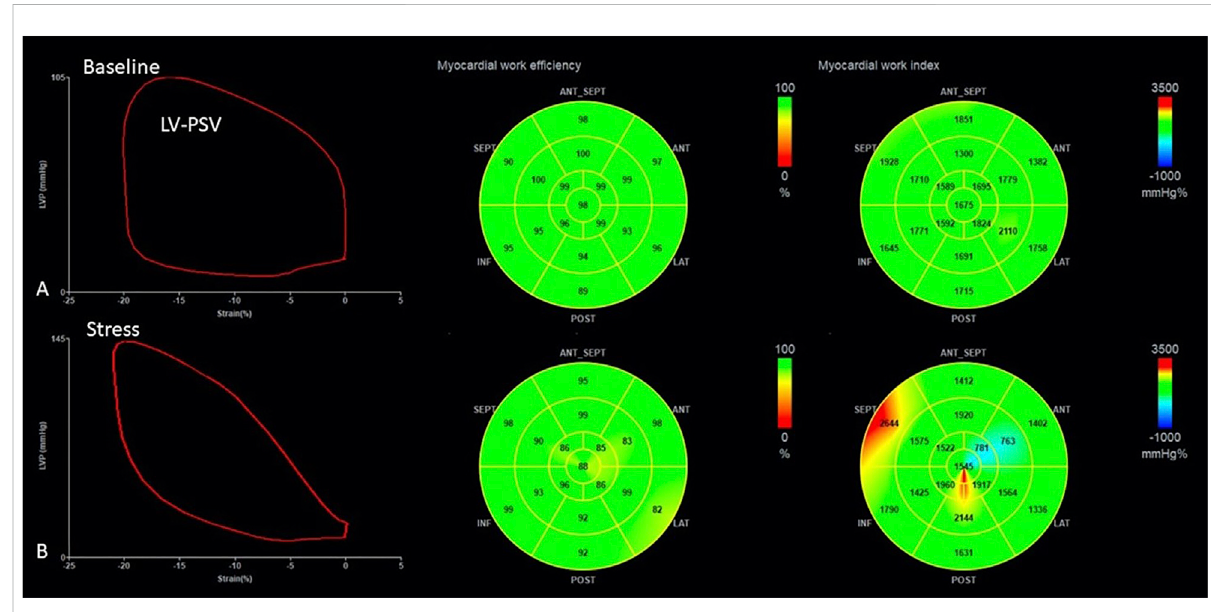
FIGURE 1 Measurement of myocardial work parameters by 2D echocardiography both at baseline (A) and during stress (B) . The left panel demonstrates thegeneratedLVpressure – strainloop;Themiddleandtherightpanelsarebull ’ seyeplotofGWEandGWI,respectively.GWE,globalworkef fi ciency; GWI, global work